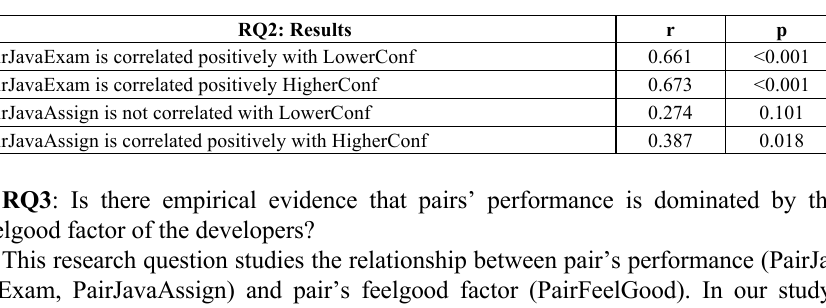
Table 6. Results summary of RQ2 (extended)